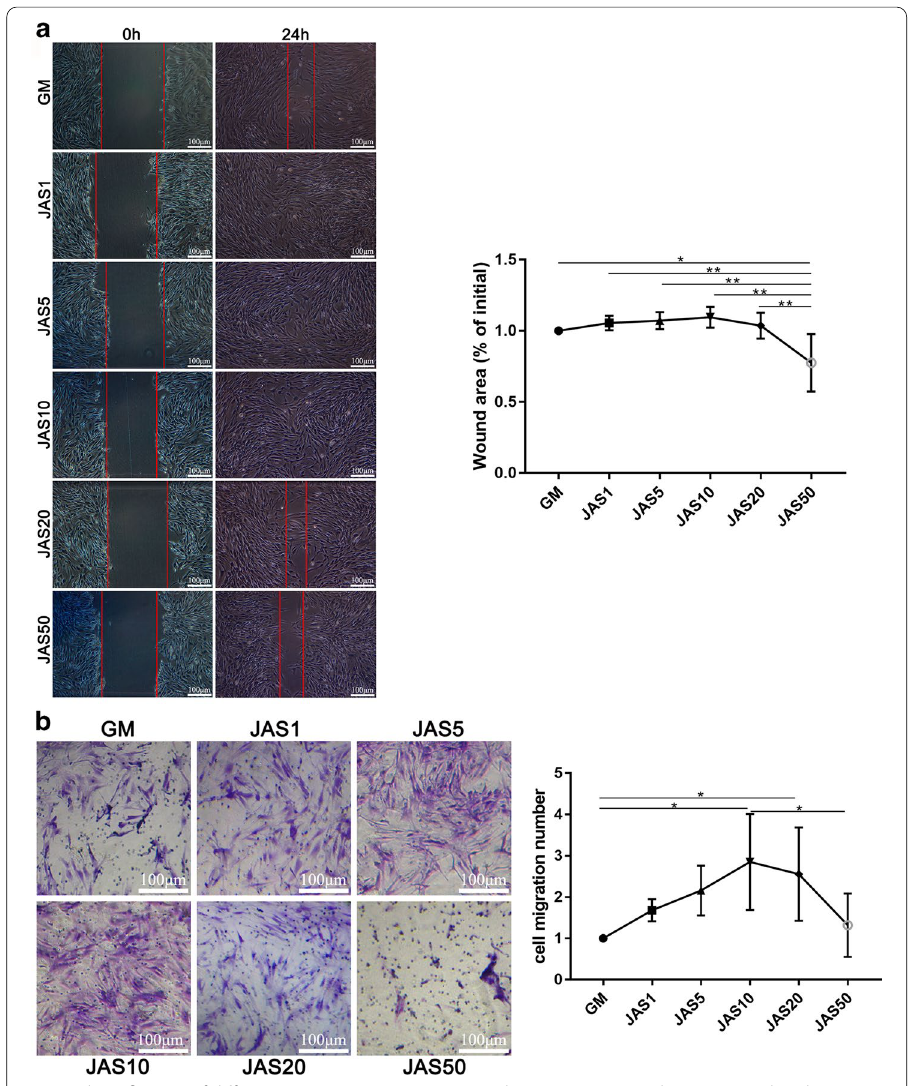
Fig. 3 The influence of different actin aggregation states on hASCs migration. a hASCs were plated on a fibronectin-coated 6-well plate. When cells were completely attached to the plate, confluent monolayers were scratched, and images were captured by microscopy at 0 and 24 h after the scratch. Quantification of the wound area at 0 and 24 h was performed using Image J. The wound area was calculated as the percentage of the initial wound area (0 h). b We suspended the cells in complete medium without FBS, added 100 μL of the cell suspension to the Transwell chamber, and then added medium (20% FBS) with different concentrations of JAS to the lower chamber. After 24 h, cells were stained with 0.1% crystal violet, and cell counting was performed using Image J. Results are expressed as mean bar 100 =